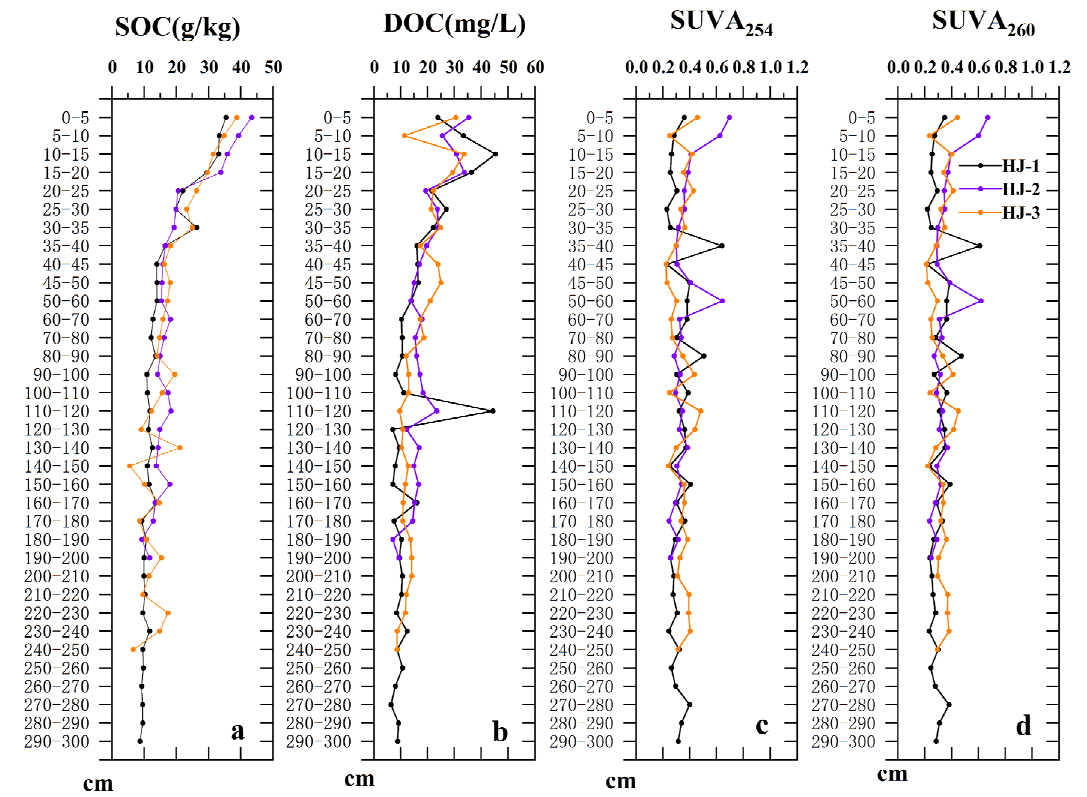
Figure 2. The contents of SOC ( a ), DOC ( b ), SUVA 254 ( c ), and SUVA 260 ( d ) in each layer of fissure soil. SUVA 254 , SUVA 260 (L · mg C − 1 · m − 1 ).